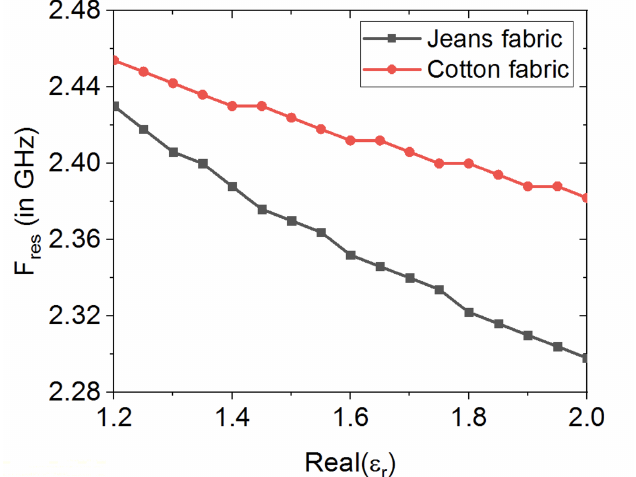
Figure 6. Numerical study on effect of textile fabrics’ electric permittivity on loop antenna’s resonance frequency.